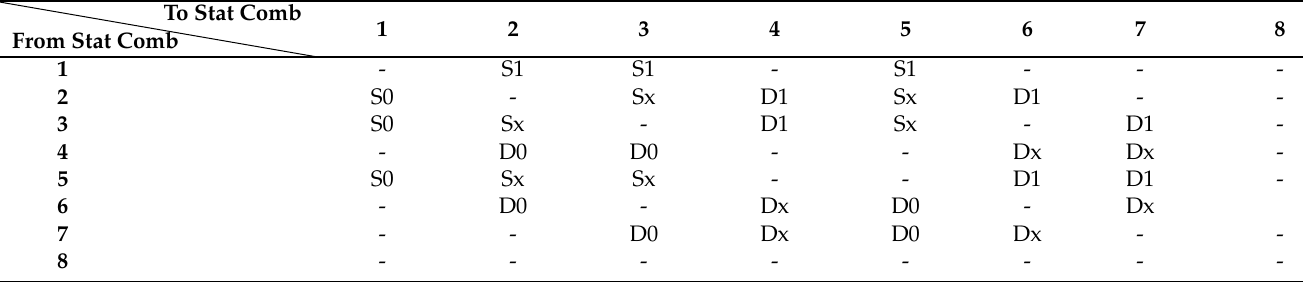
Table A2. Status combination changes and regime changes for a 2 + 1 configuration.